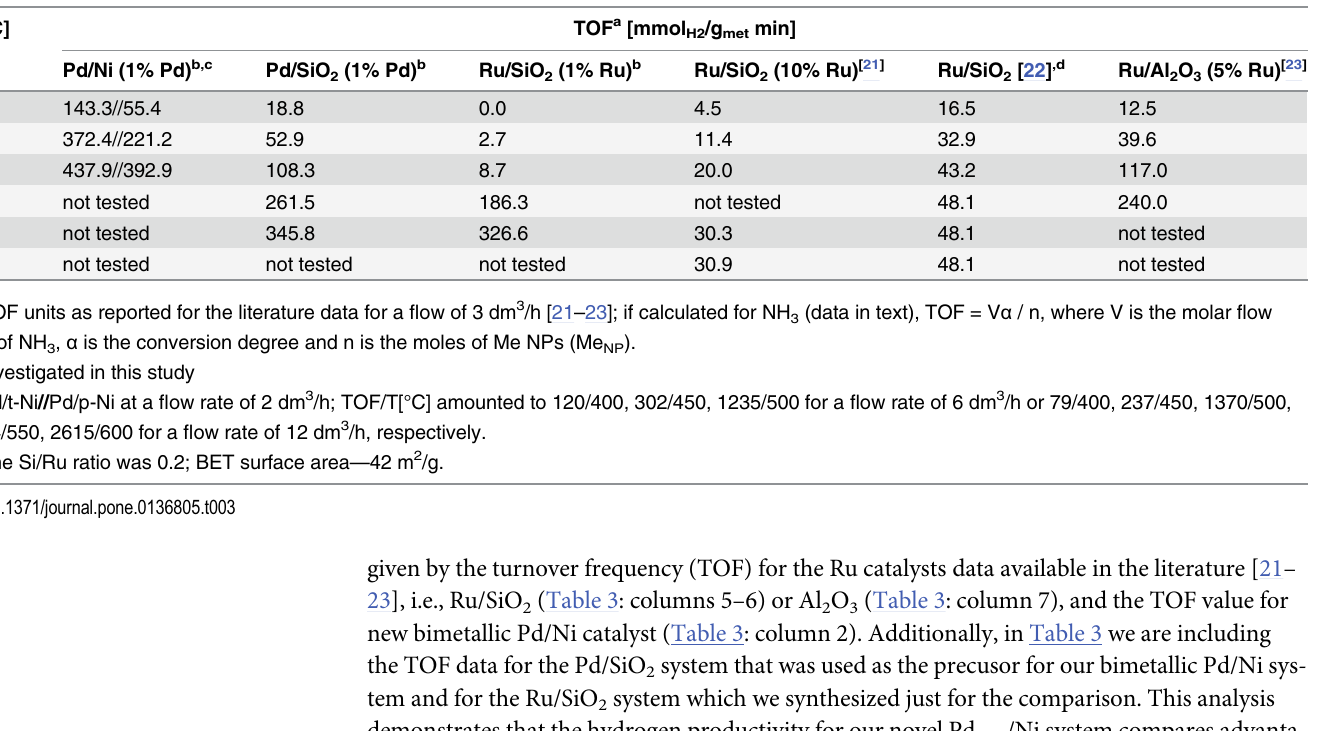
Table 3. Comparison of the TOFs for the investigated Pd NPs /Ni (Pd NPs /SiO 2 ) and the most reactive Ru systems [21 – 23]. T [°C] TOF a [mmol H2 /g met min] Pd/Ni (1% Pd) b,c 143.3//55.4